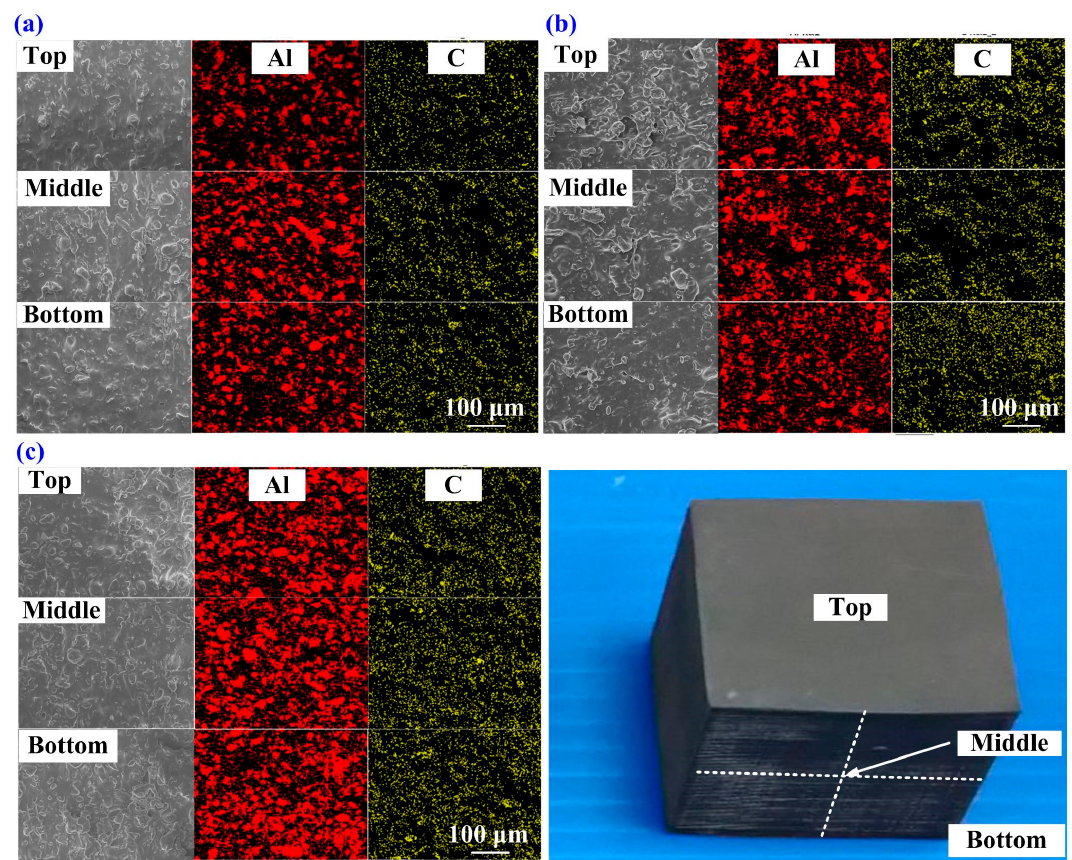
Figure 9. Energy-dispersive X-ray spectroscopy (EDS) images of the specimens made with recipes ( a ) 6, ( b ) 4, and ( c ) 2.